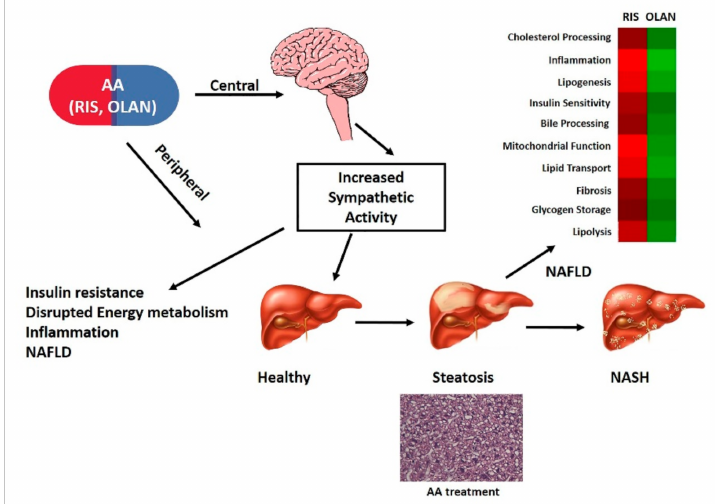
Figure 5. Model of antipsychotic regulation of NAFLD via sympathetic nervous system (SNS), metabolic, inflammatory, and endocrine factors. We propose that antipsychotic (AA) associated increase in sympathetic activity impacts the liver by causing alterations in the hepatic proteome and associated pathways leading to hepatic steatosis and NAFLD. A hematoxylin and eosin stained liver from OLAN-treated mouse at 20 × magnification and pathway analysis heat maps (red-shading—RIS; green-shading—OLAN) are shown in support of this